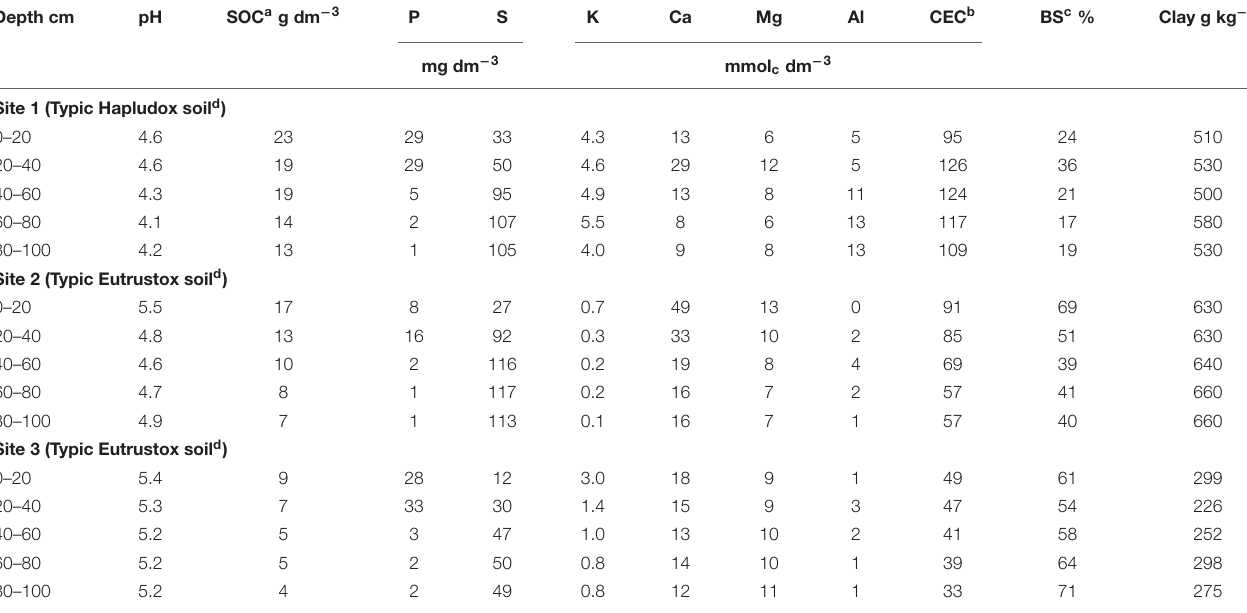
TABLE 1 | Selected physicochemical soil properties at the 0- to 100-cm soil layer before the onset of field trials cropped with sugarcane at three sites, all located in the Southeast region of Brazil. Depth